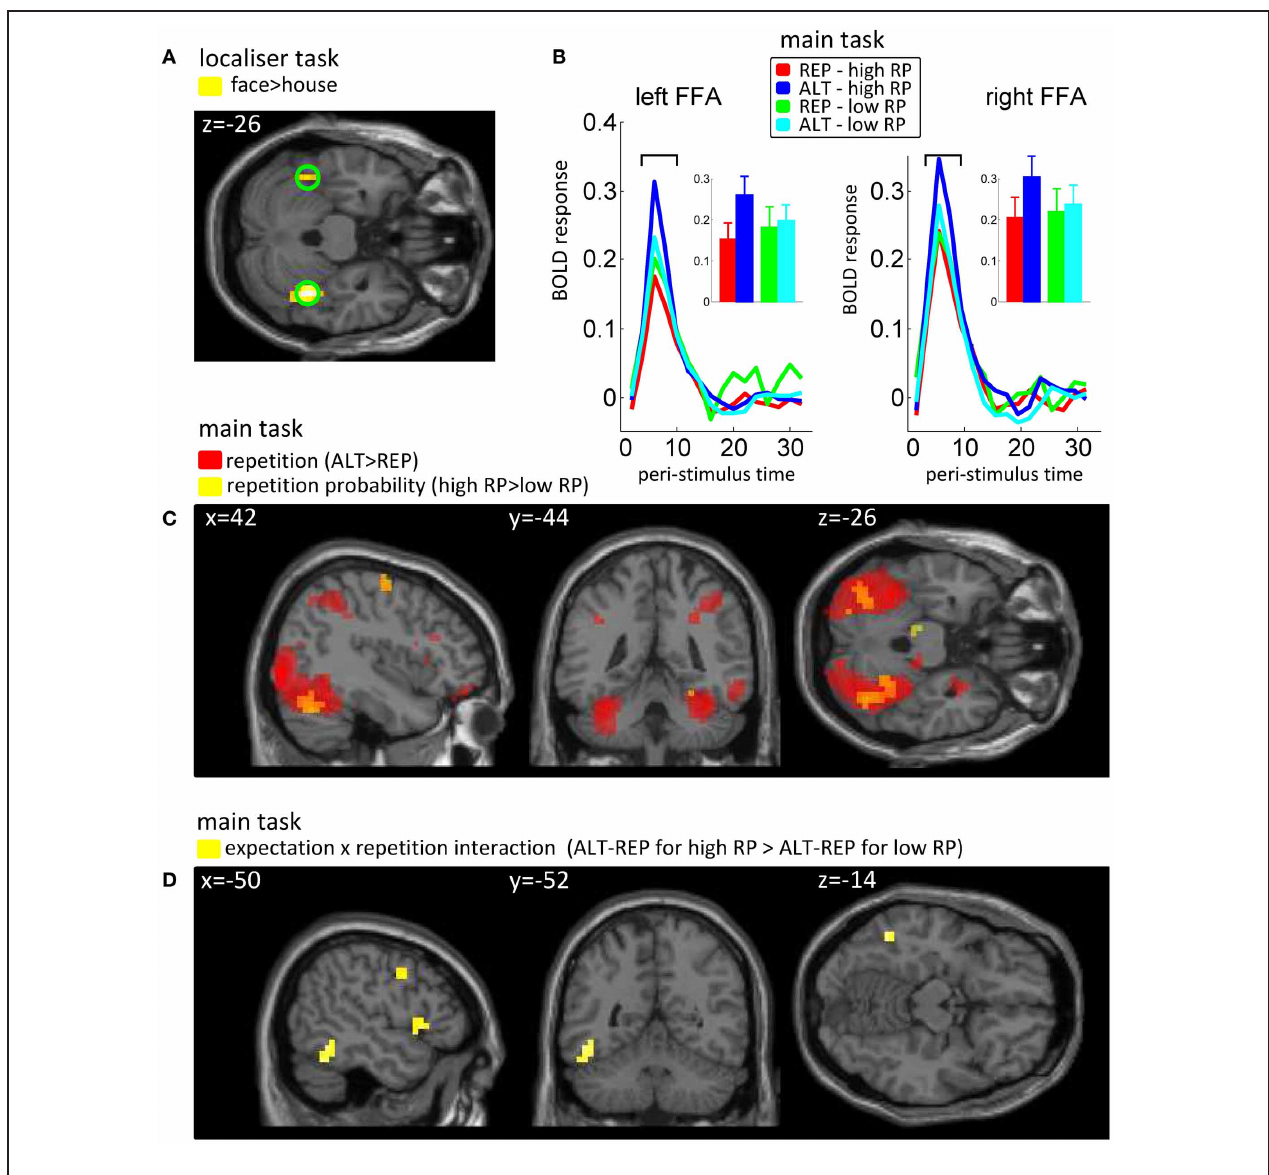
onset), for the 4 conditions of our design. (C) Main effects of expectation (repetition probability, RP) and repetition in the whole brain analyses, reported at a threshold of p < 0 . 005 and k = 10. On top of the sagital, coronal and axial views are reported the x , y and z coordinates in the MNI system. (D) Interaction between expectation (repetition probability, RP) and repetition. Same conventions as